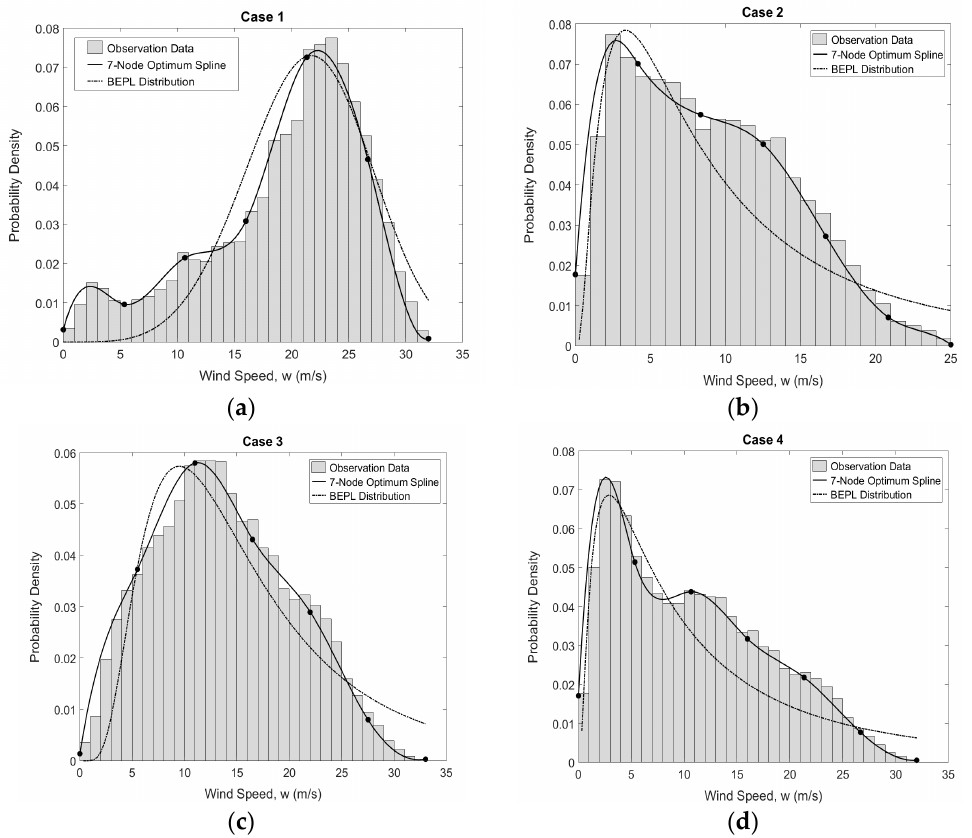
Figure 5. Comparison of the spline based and the Beta Exponentiated Power Lindley fits with the observed data. ( a ) Multimodal distribution 1; ( b ) Multimodal distribution 2; ( c ) Unimodal distribution; ( d ) Multimodal distribution 3.